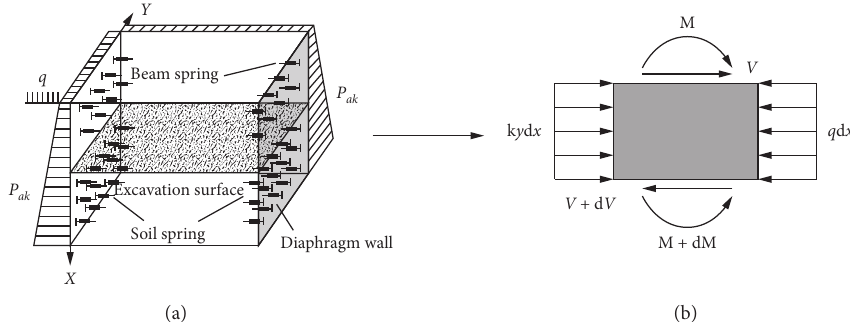
Figure 2: Mechanical model of the elastic foundation beam. (a) The retaining system. (b) Basic